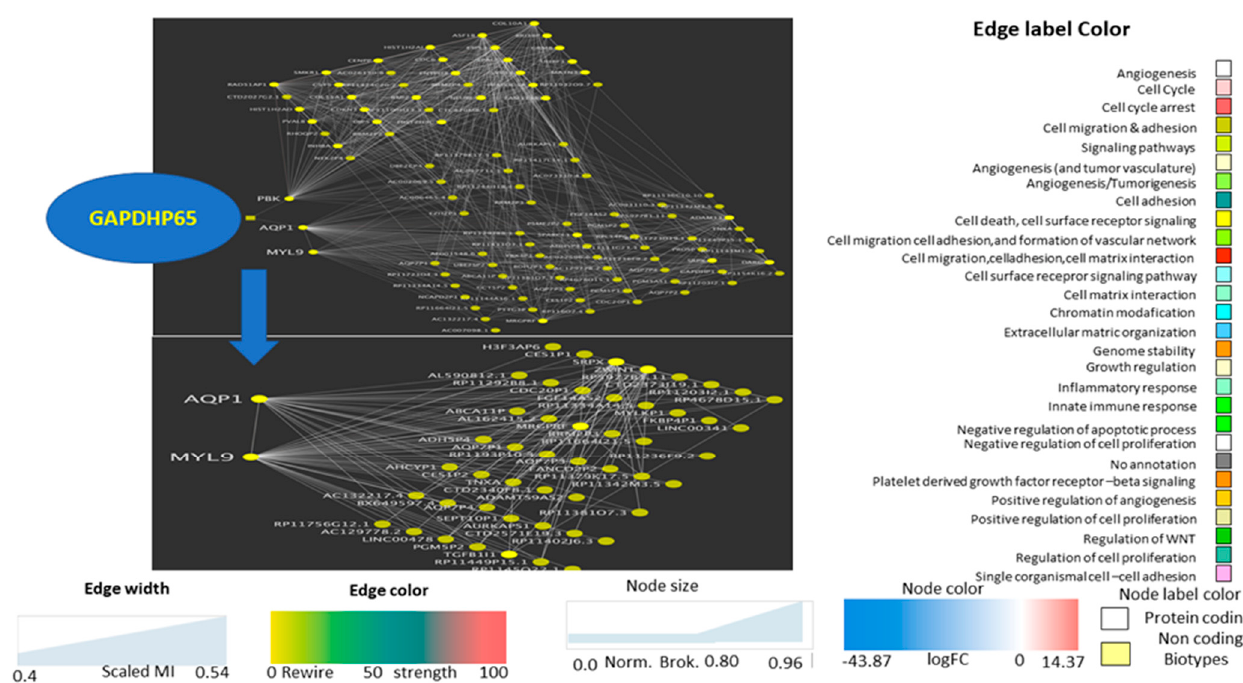
Figure 3. Top panel. Luminal map and top brokerage ncRNAs: TNXA, AQP7P4, FGF14AS2, GAPDHP65, RRM2P4. Red arrows indicate graph extension. Bottom panel. Annotations and linked GAPDHP65 subnetwork.